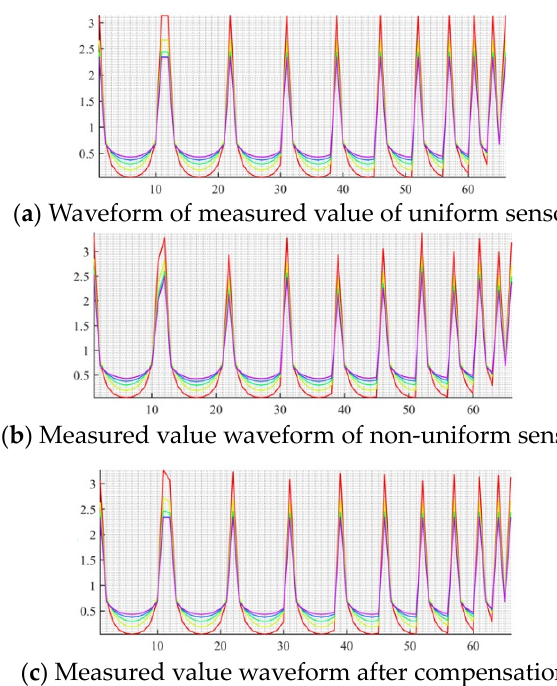
electrode spacing angle and the sensor with non-uniform electrode spacing angle when Figure 5. Waveforms of measured values before and after center current compensation. Figure 5. Waveforms of measured values before and after center current compensation. the medium distribution is set to the annular flow.